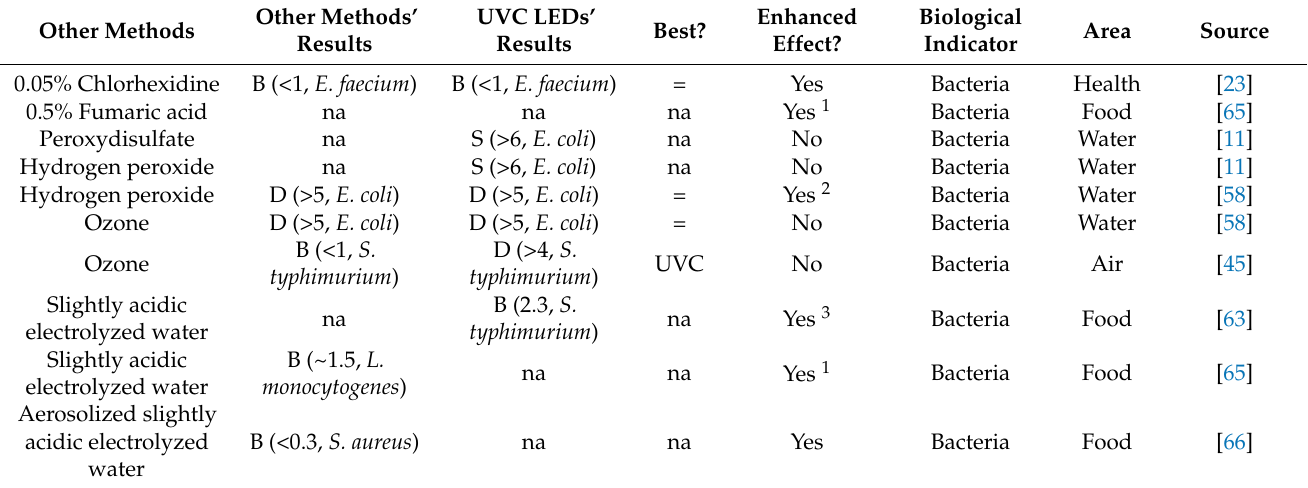
Table A2. Comparison between the decontamination effectiveness of UVC LEDs and chemical